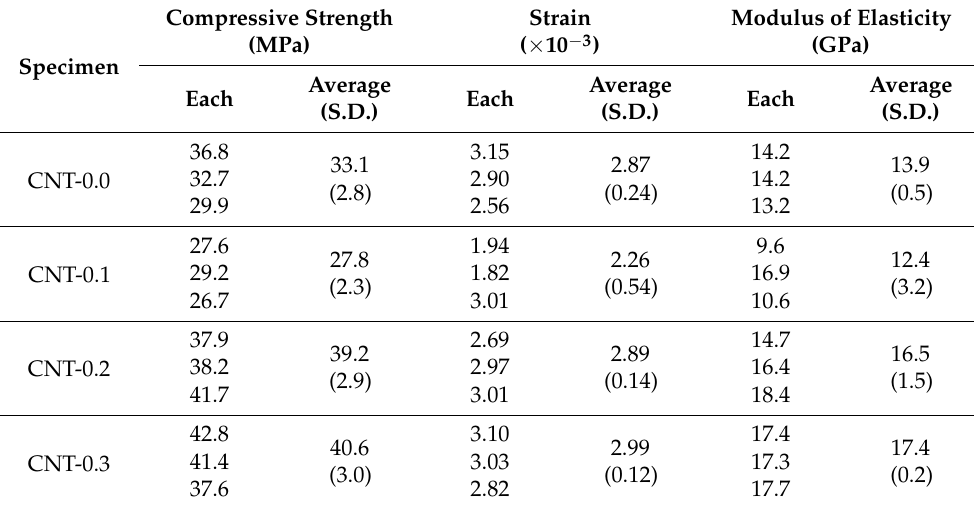
Table 6. Summary of the compression test